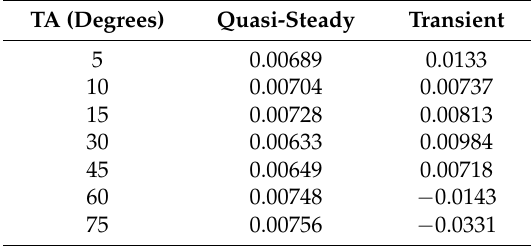
Table 5. Rotor thrust coefficient at several TAs by both methods.